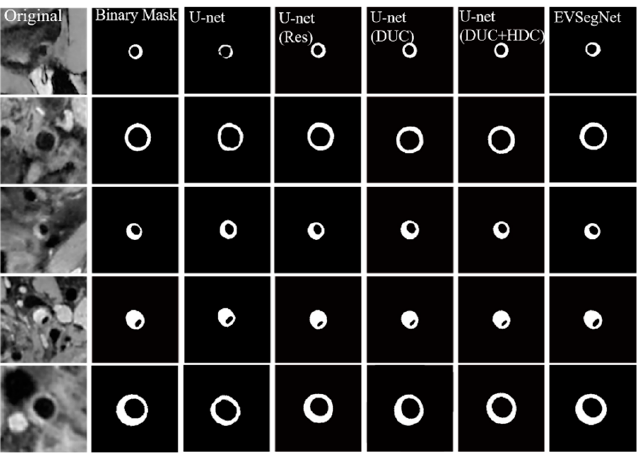
Figure 9. Visualization of the segmentation outputs with different backbone architecture, U-net